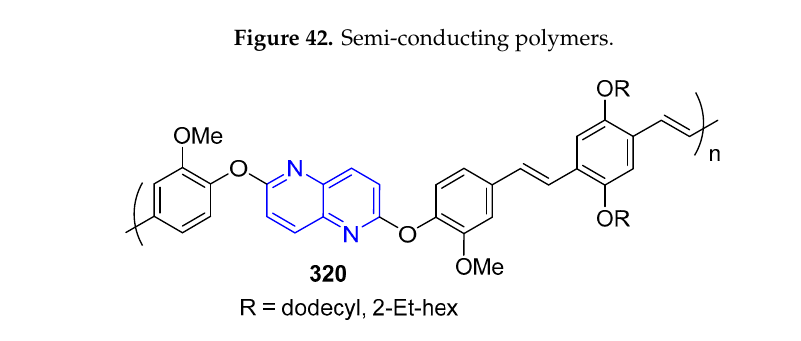
Figure 43. Iodide ion detectors.